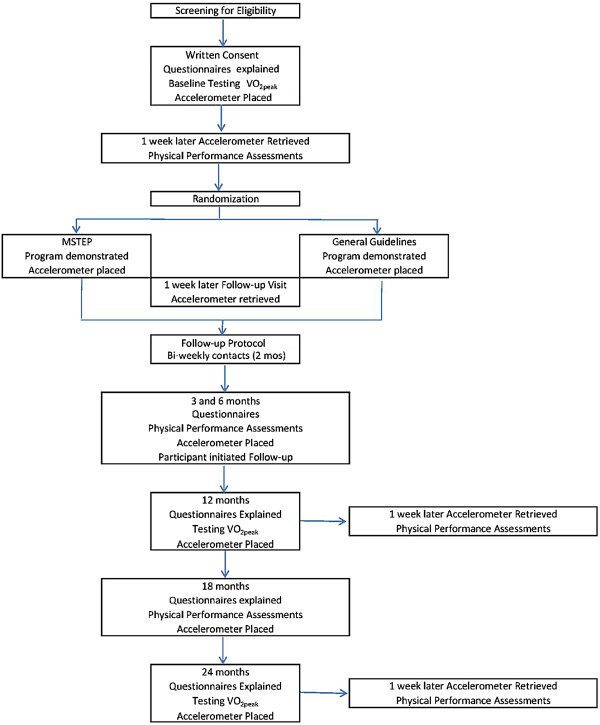
The path of participants through the study protocol.